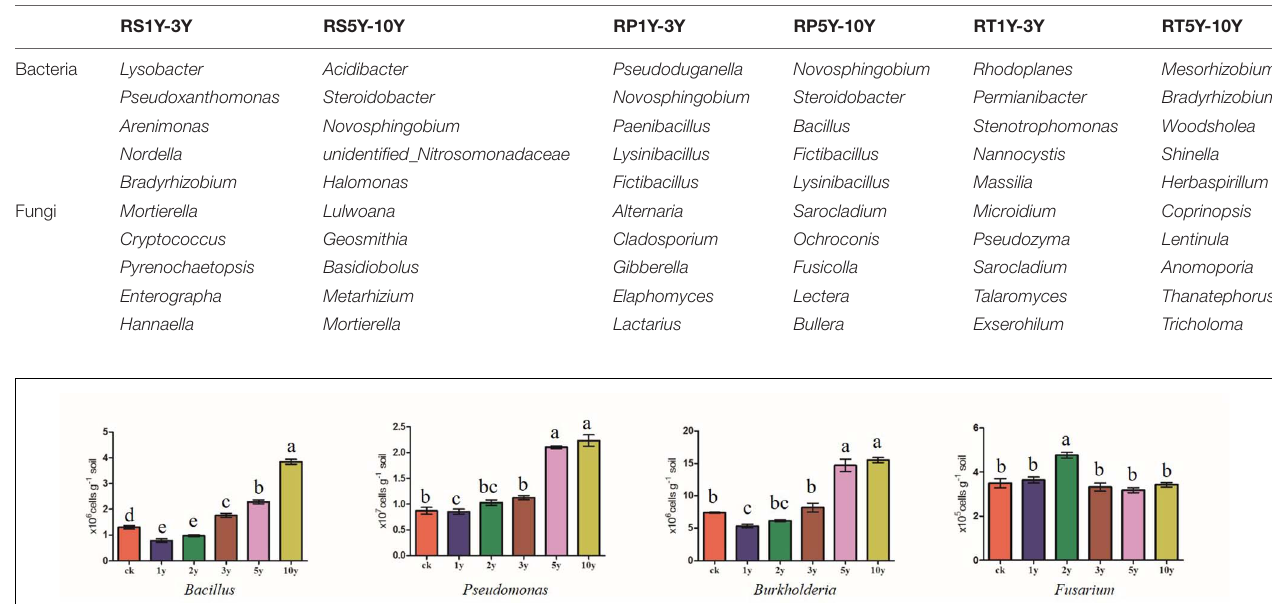
TABLE 1 | The keystone genera in the networks of bacterial and fungal communities.